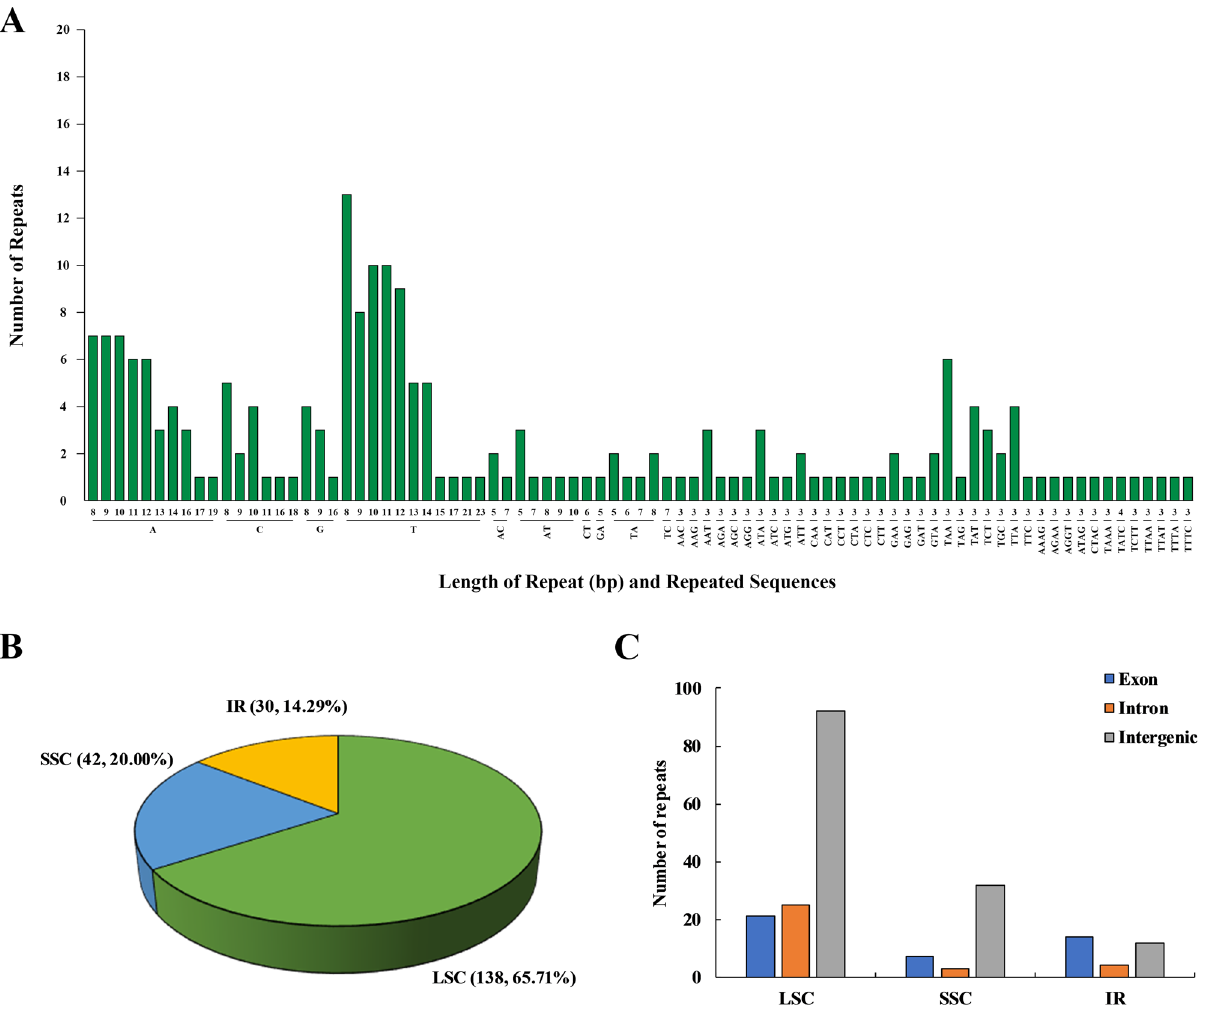
Figure 3. SSR analysis of S. lepifera . ( A ) SSR type. ( B ) The number of SSR in different regions. ( C ) Distribution region of SSR in